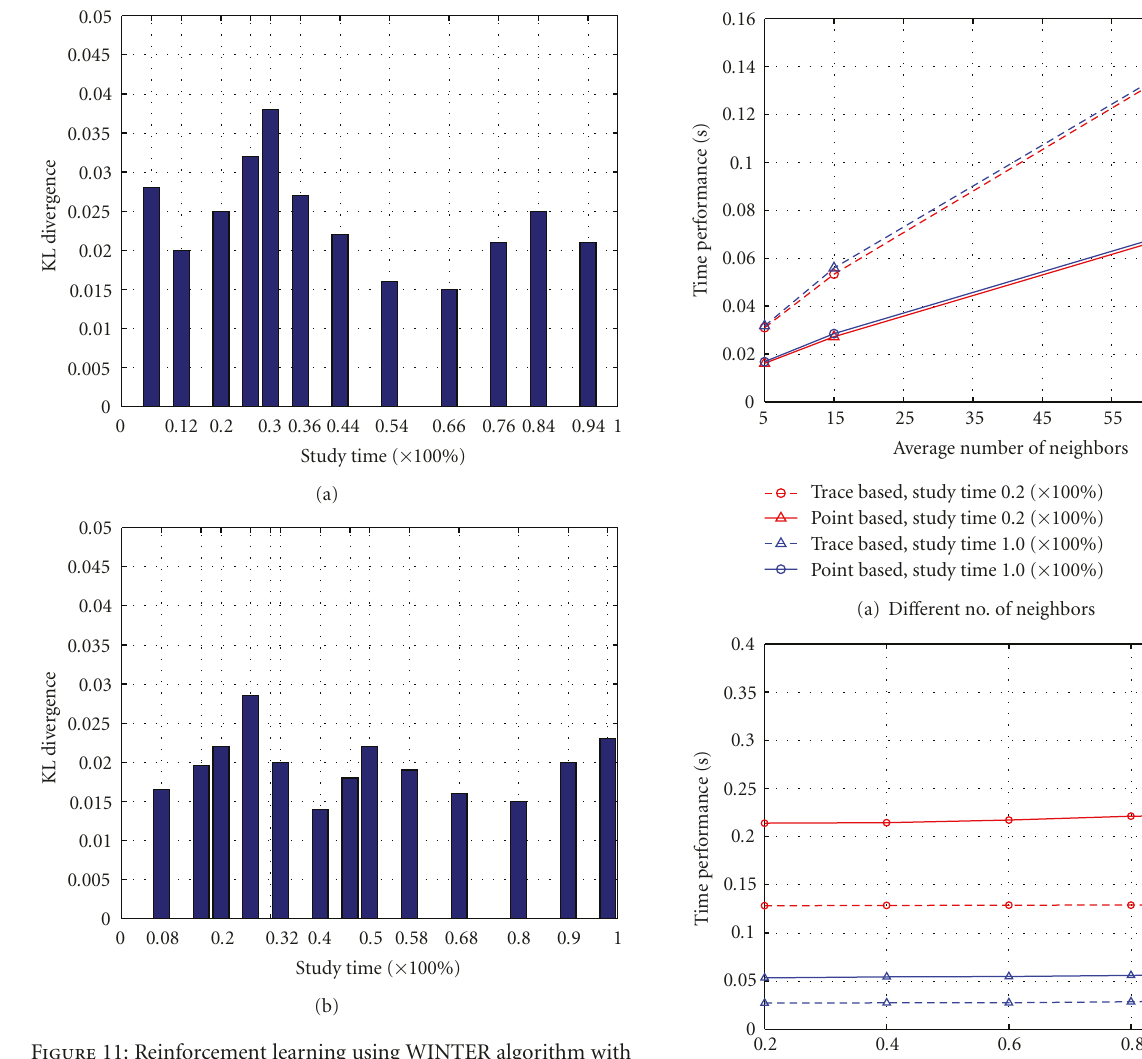
Figure 11: Reinforcement learning using WINTER algorithm with double study time in walking scenario: (a) initial prediction window size is set to 0.04 and the future testing window size is set to 0.06; (b) initial prediction window size is set to 0.06 and the future testing window size is set to 0.04.